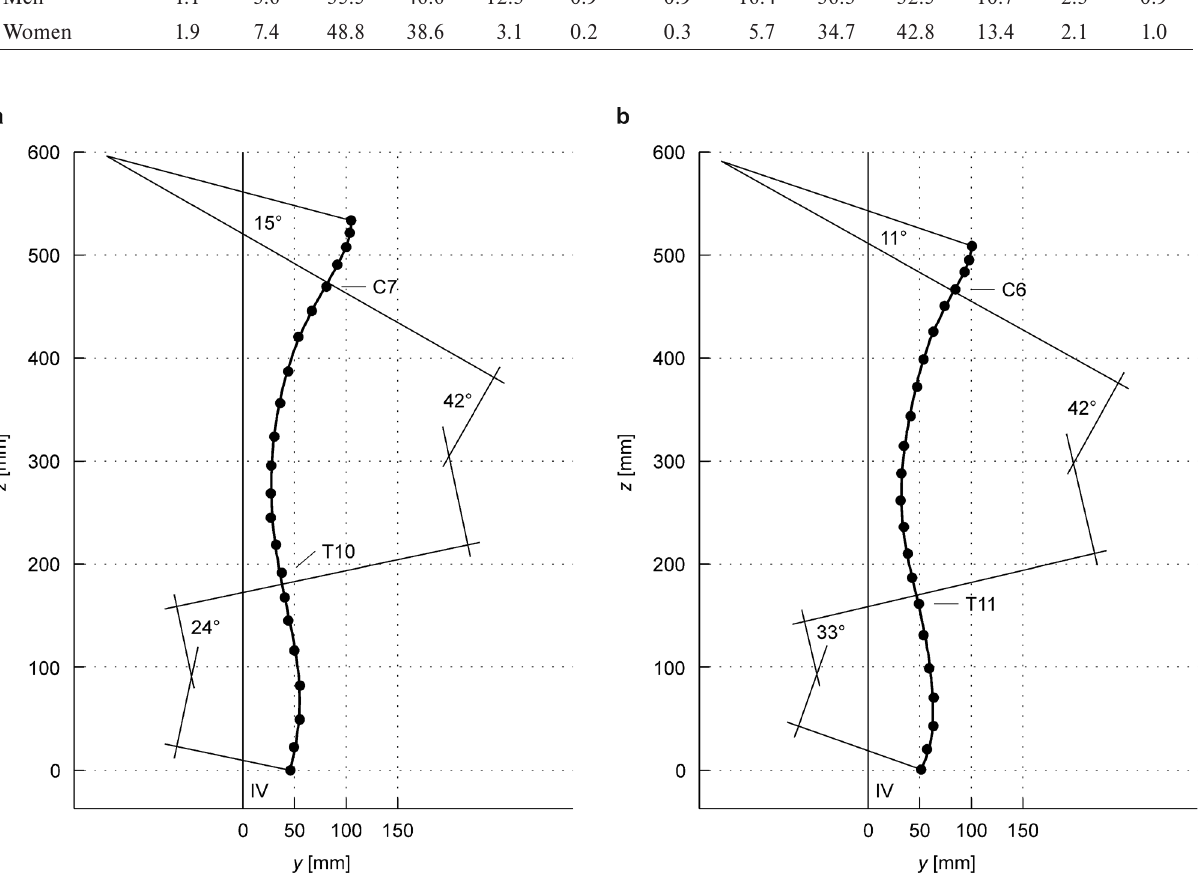
Figure 2. Typical cases of sagittal spinal shape of a man (a) and a woman (b). Typical case was chosen as a shape of one subject whose spinal variables were closest to average values presented in Table 1. IV = vertical line erected from the centre of the connecting line between the calcanei.